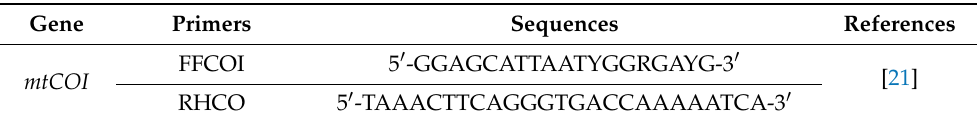
Table 1. Set of primers used for the amplification of mitochondrial cytochrome c oxidase subunit I ( mtCOI ) gene using extracted DNA of O. ovis larvae.